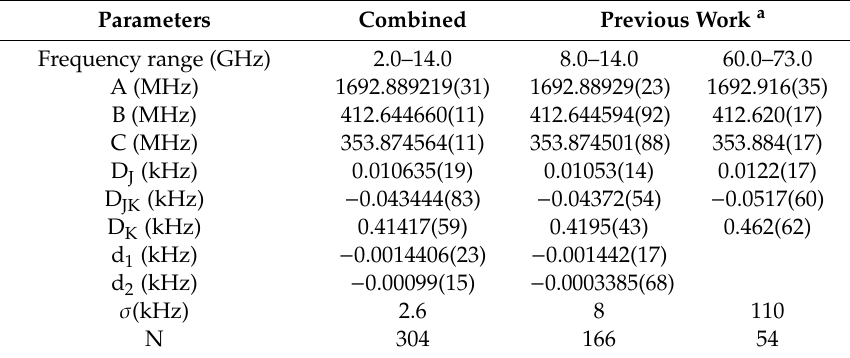
Table 2. Fit spectroscopic parameters for